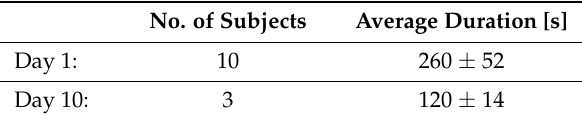
Table 1. Subjects and record